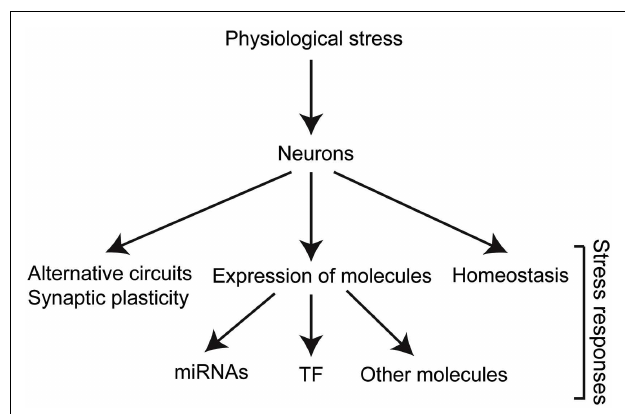
FIGURE 1 | Different aspects of physiological stress. Aging and environmental stress are present throughout life whereas intrinsic developmental stress applies only during embryonic and post-embryonic development.